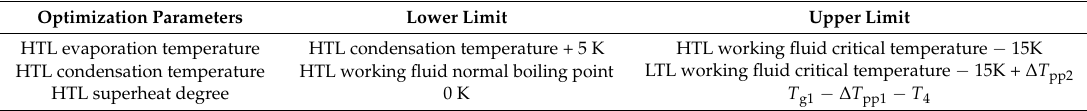
Table 4. Optimization ranges of the operating